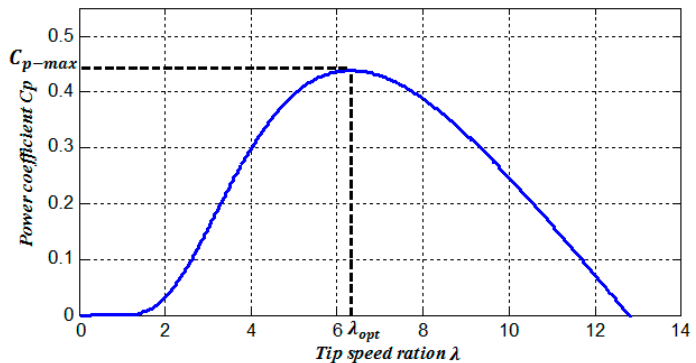
Figure 1. C (cid:2926) − λ characteristic. Figure 1. C p − λ